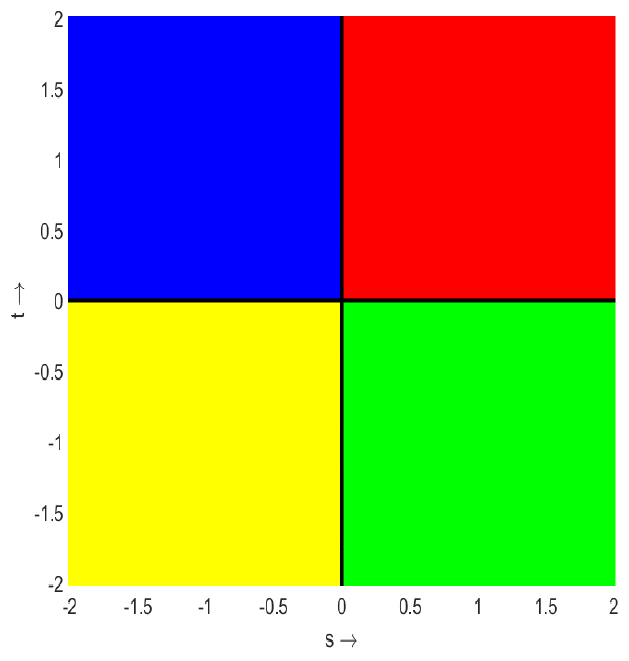
Figure 9. Dynamics of the method (4) associated with BA of Example